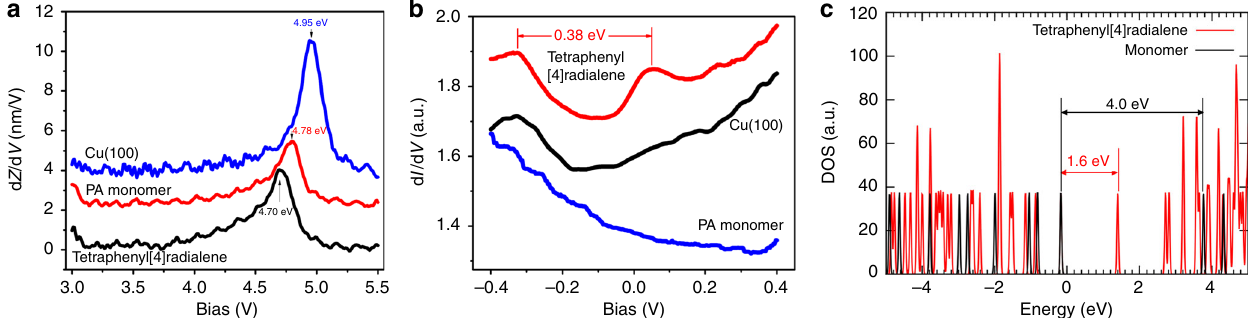
Fig. 7 Spectra measurements for the clean Cu(100) surface, single PA molecule and the tetramer. d Z/ d V ( a ) and d I /d V ( b ) spectra acquired on bare Cu (100), isolated PA monomers and newly formed tetraphenyl[4]radialene products. c The calculated HOMO – LUMO levels for isolated PA monomer